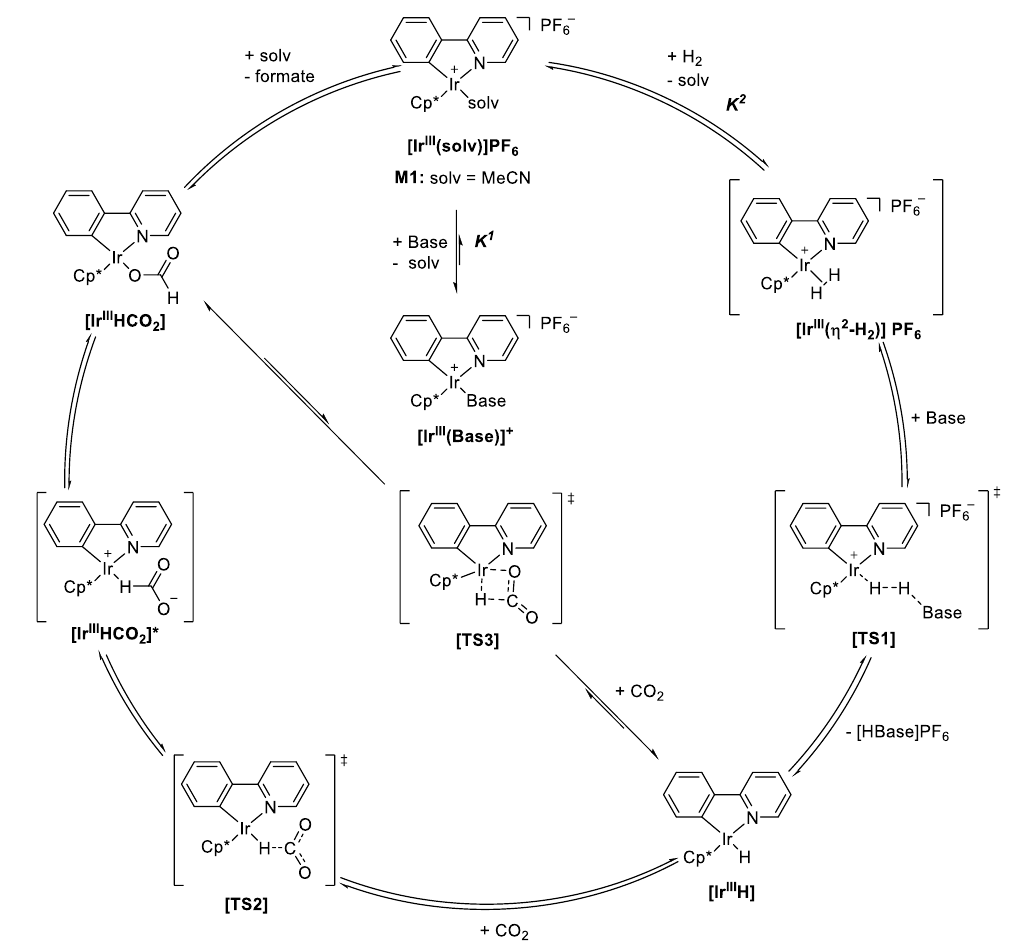
Figure 4. Proposed catalytic scheme for CO 2 hydrogenation using a monometallic iridium catalyst (Cp* = C 5 Me 5 ).